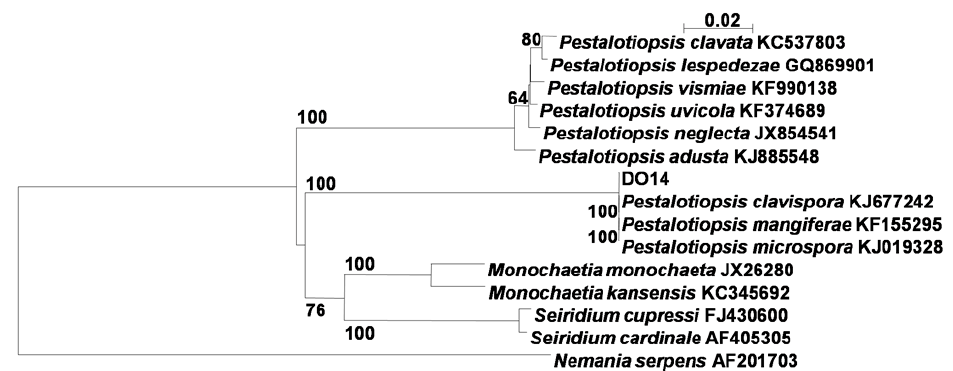
Figure 1. Phylogenetic tree of the endophytic fungus DO14 based on 5.8 S and ITS regions sequences. Bootstrap values above 50% (1000 replicates) are shown at branches. Nemania serpens is used as an out-group.